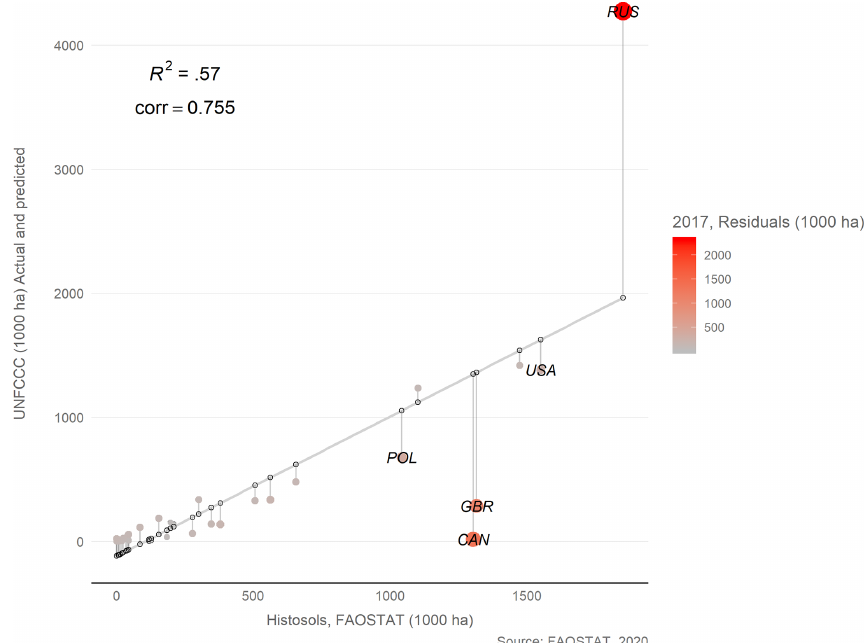
Figure 10. Comparison of FAOSTAT estimates of drained organic soils area vs. official country data reported to UNFCCC (year 2017). Distance from predicted (on the fitted line) and actual